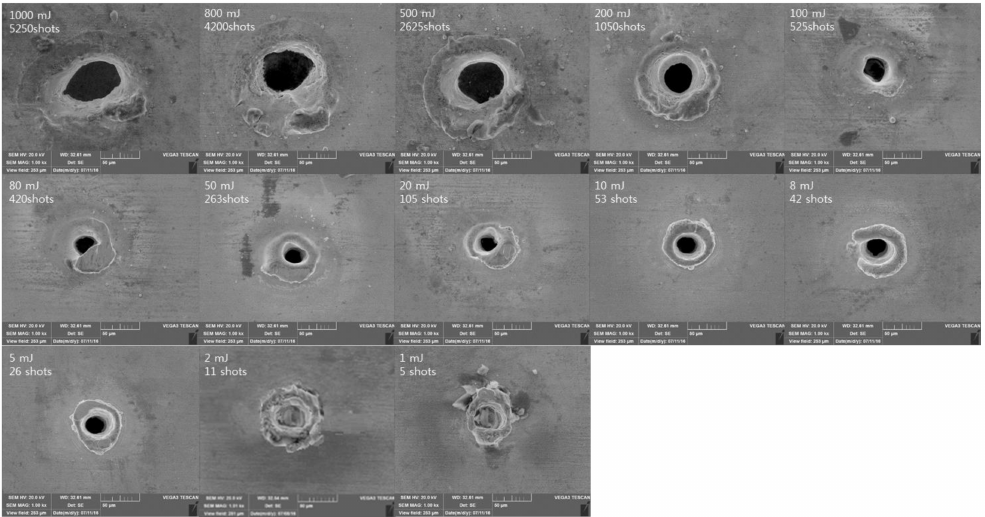
Figure 12. SEM images of laser ablation with ∆ t = 20